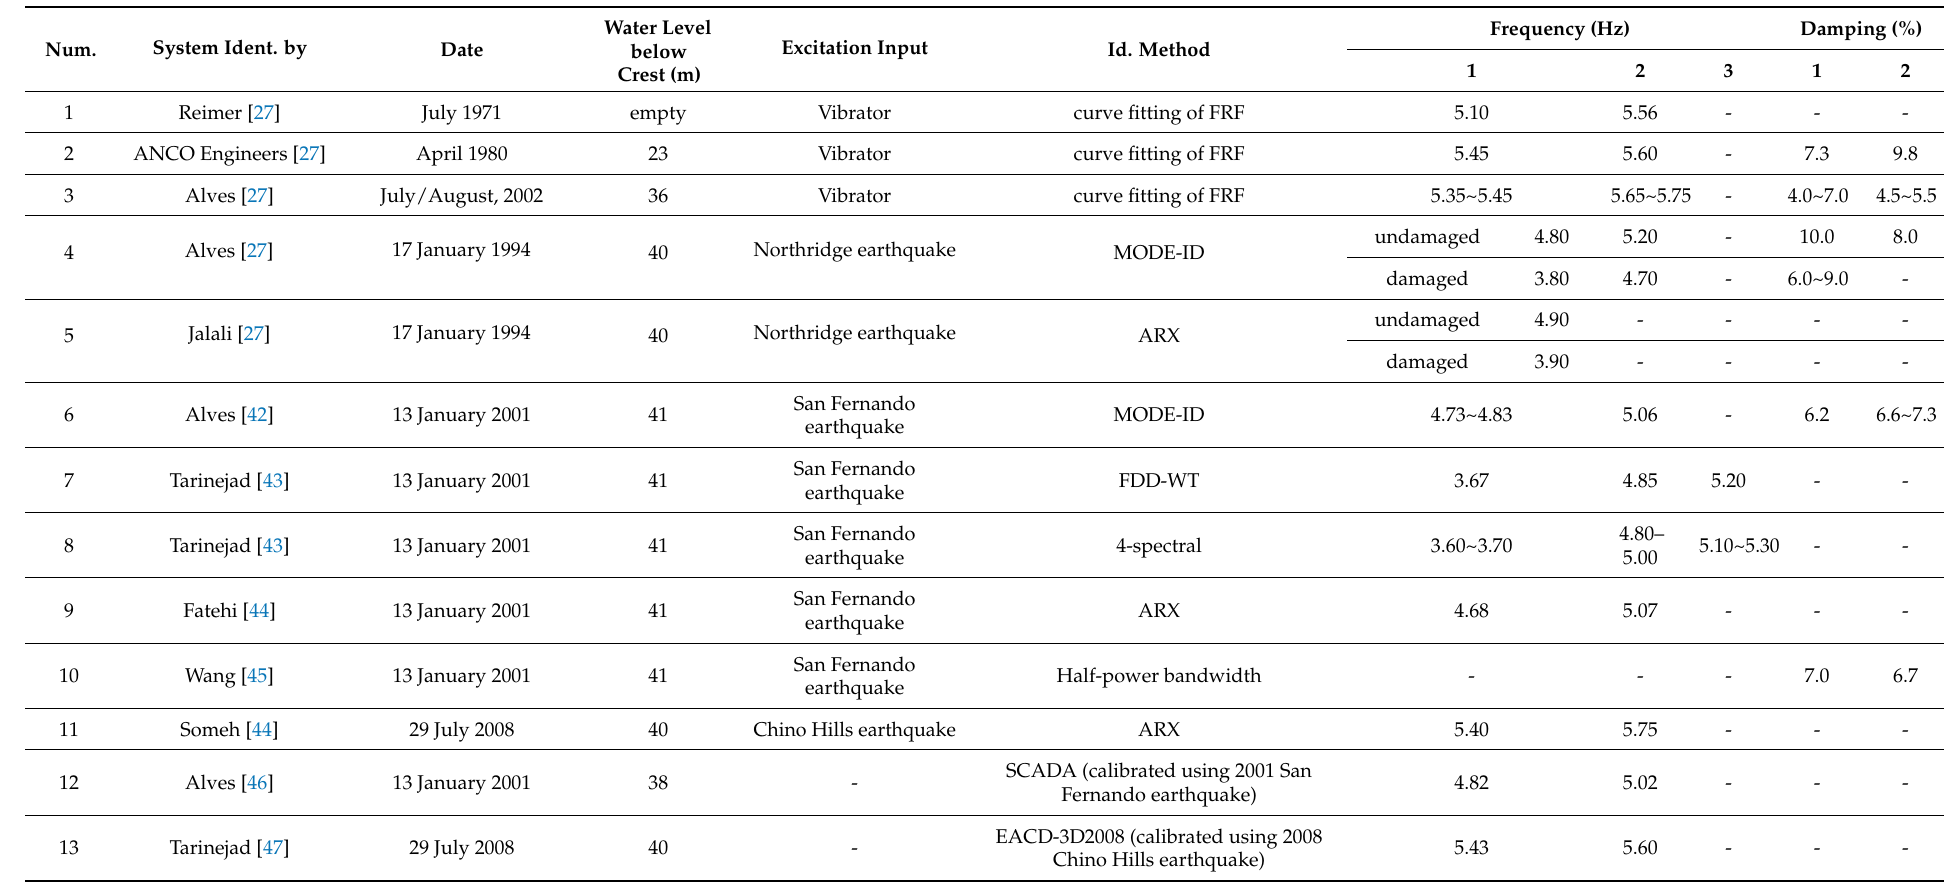
Table 3. Statistics on the results of the self-resonance frequency and the damping ratio of the Pacoima arch dam by different scholars.